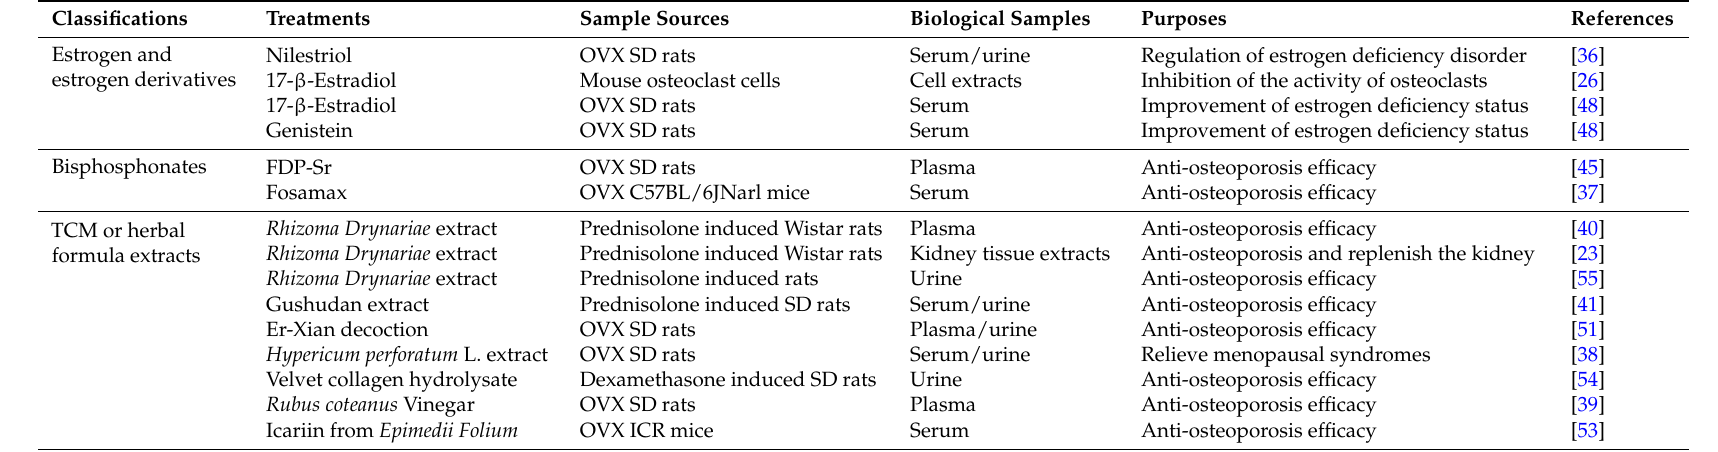
Table 3. Treatments for osteoporosis evaluated by metabolomics